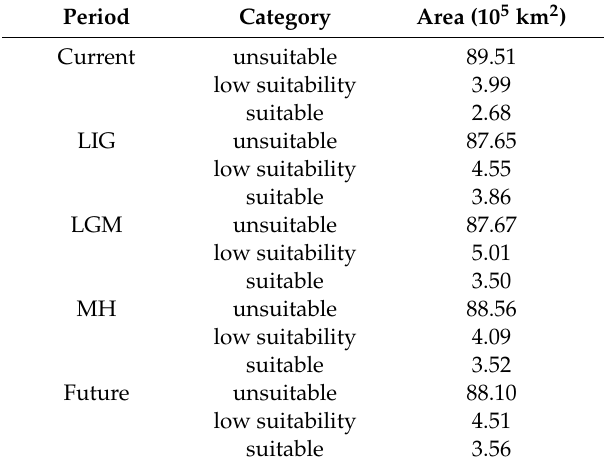
Table 9. The area of suitable area of L. chinense in five